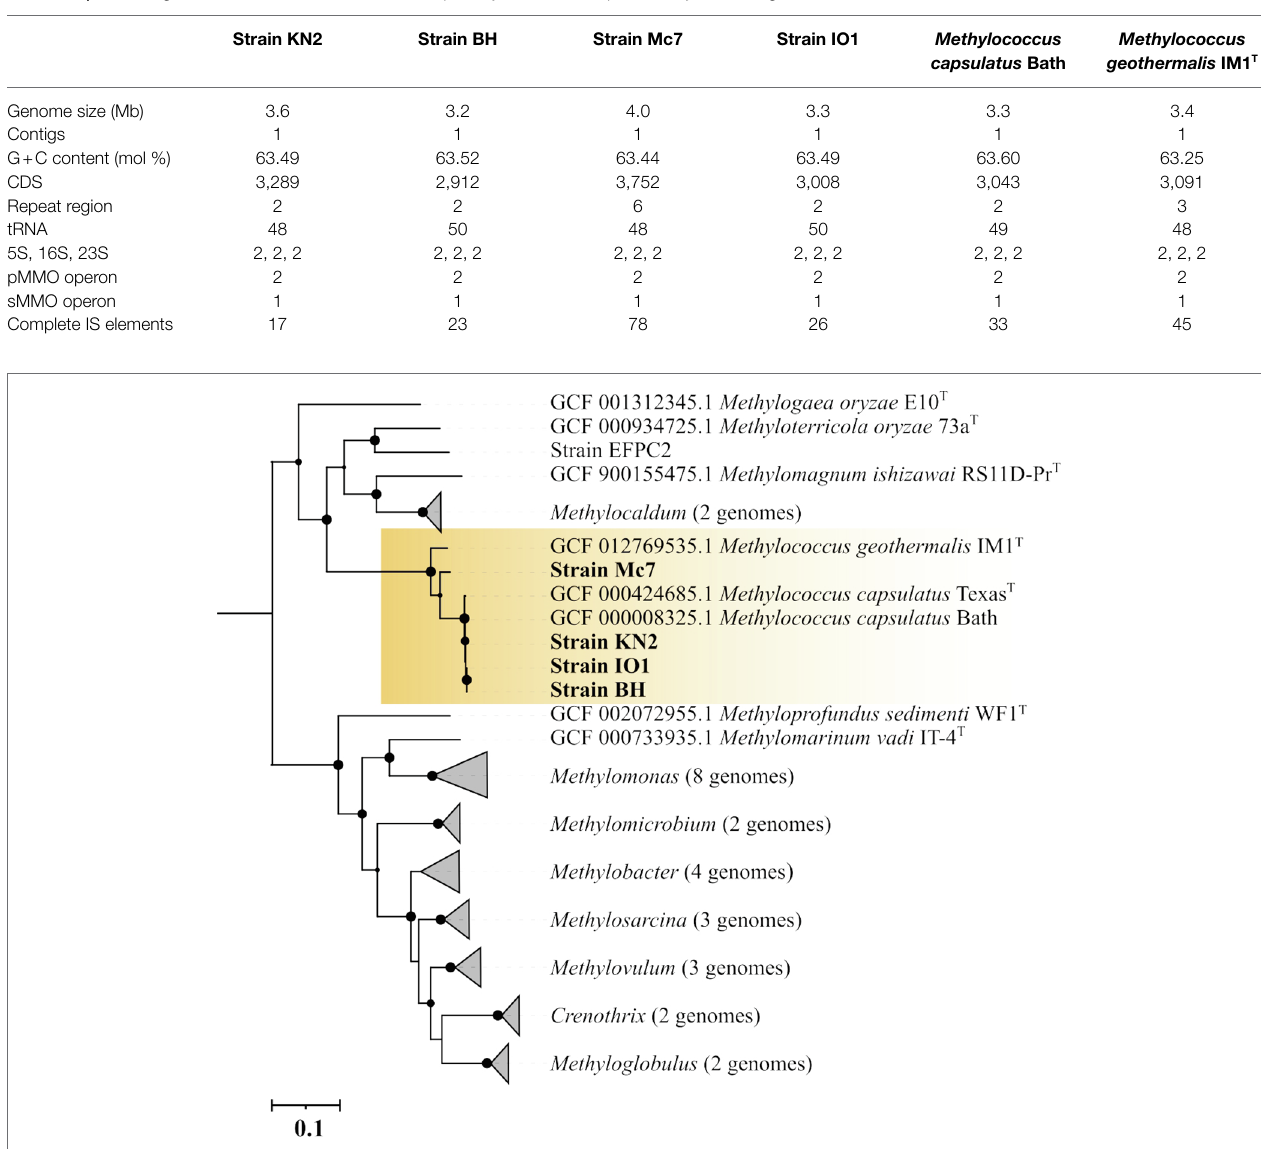
TABLE 2 | General genome features of new isolates and publicly available complete Methylococcus genomes.